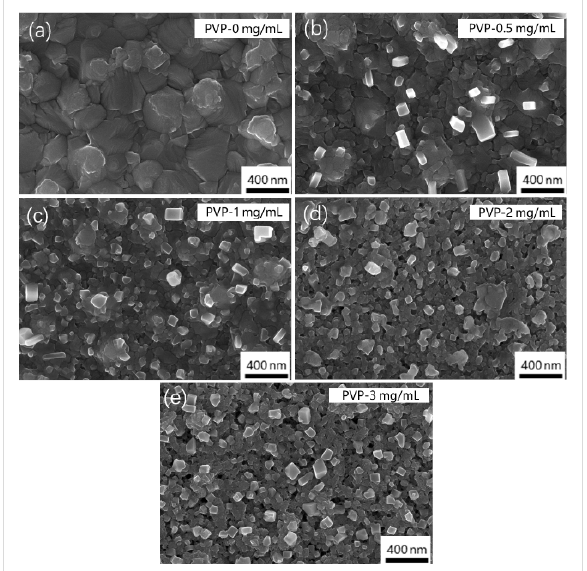
tration of the MAX solution was 40 mg/mL MAI and 10 mg/mL MACl) for 500 s to prepare the CH 3 NH 3 PbI 3 layer, and the films were dried by spinning at 3000 rpm for 10 s and annealing at 120 °C for 10 min. Subsequently, the hole trans- port layer (HTL) was spin-coated on top of the CH 3 NH 3 PbI 3 film using a Spiro-OMeTAD solution (the composition of the Spiro-OMeTAD solution was 72.3 mg Spiro-OMeTAD, 28.8 μ L 4- tert -butylpyridine, 17.5 μ L of lithium bis(trifluoro- methanesulfonyl)imide solution (520 mg/mL in acetonitrile) and 1 mL chlorobenzene) at 4500 rpm for 20 s. The above prep-